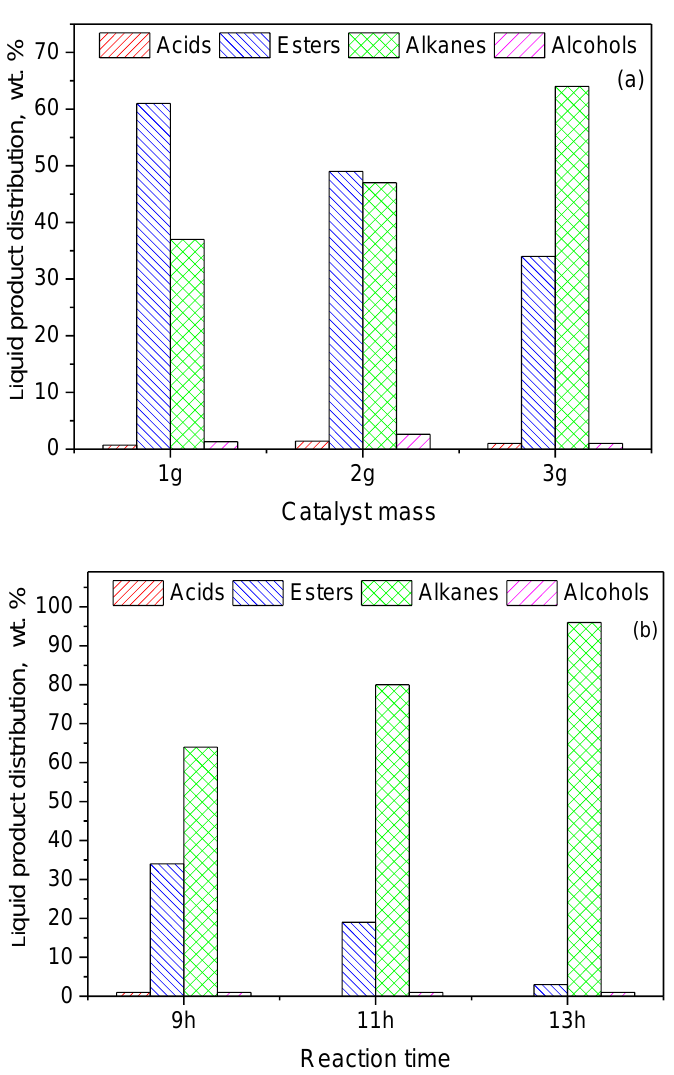
= 40 bar, H 2 flow = 100 mL/min). 2